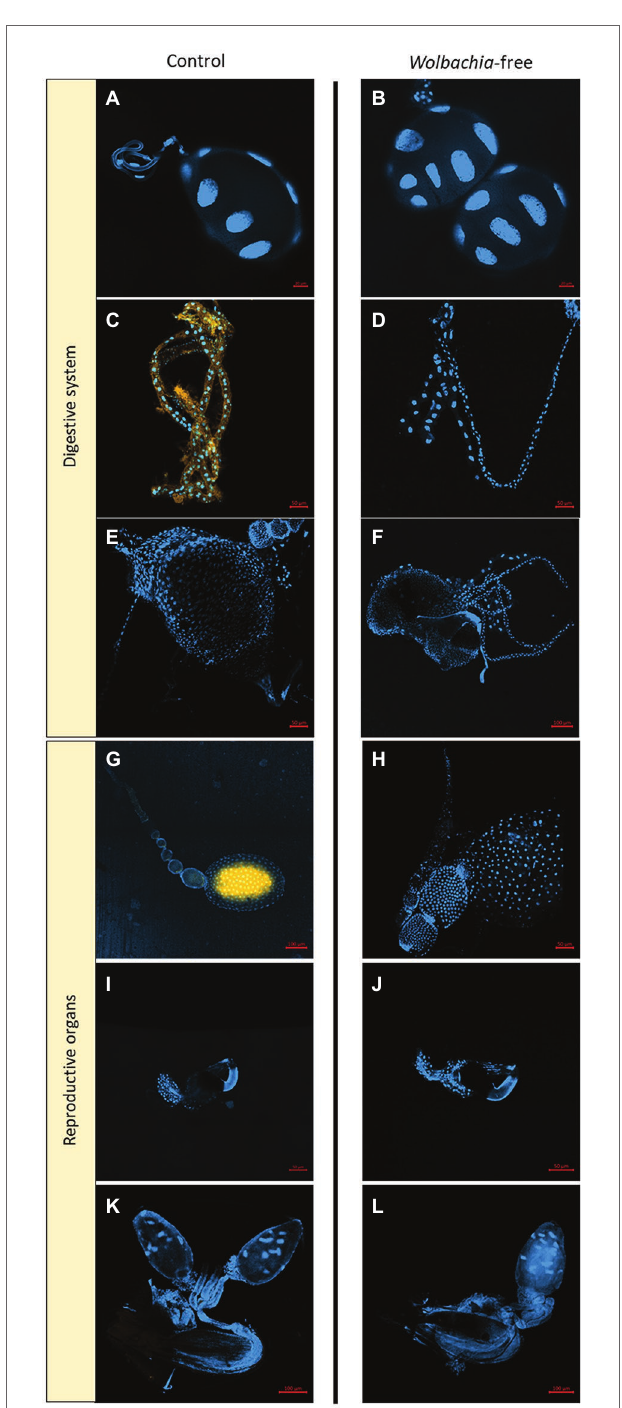
FIGURE 2 | Wolbachia localization within Synosternus cleopatrae fleas. Fluorescence in situ hybridizations of organs in the ingestion and reproductive systems of control (W + , left) and Wolbachia -free (W − , right) fleas. (A,B) saliva gland, (C,D) Malpighian tubules, (E,F) midgut, (G,H) ovary, (I,J) spermatheca, and (K,L) male genitalia. DAPI stain for double-stranded DNA is indicated in blue and the specific probe for Wolbachia is indicated in yellow. For optimal illustration, except male genitalia, all other organs were taken from female fleas, although male fleas were also tested (see